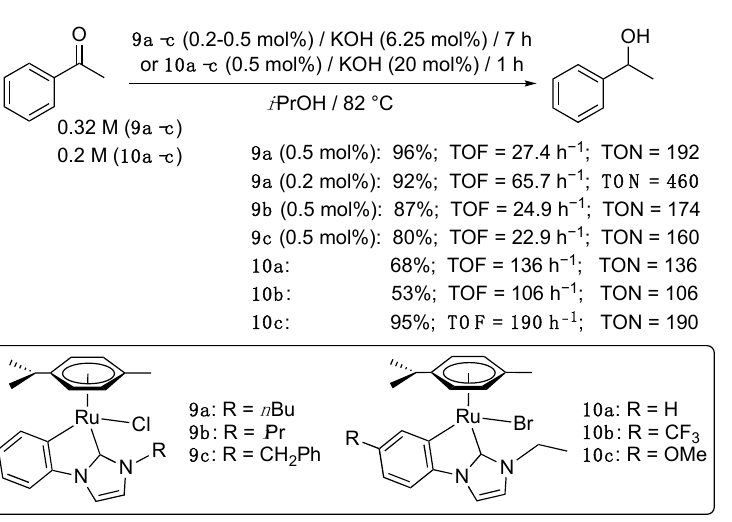
Scheme 4. TH of acetophenone catalyzed by CC -cycloruthenated complexes 9a – c and 10a – c .